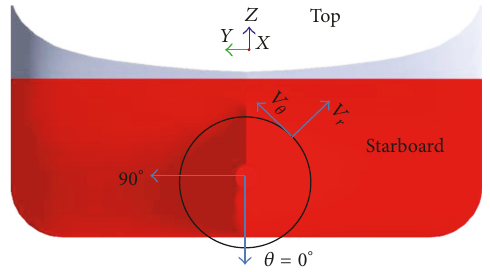
Figure 10: Definition of the circumferential degree and tangential and radial velocity at the propeller plane.